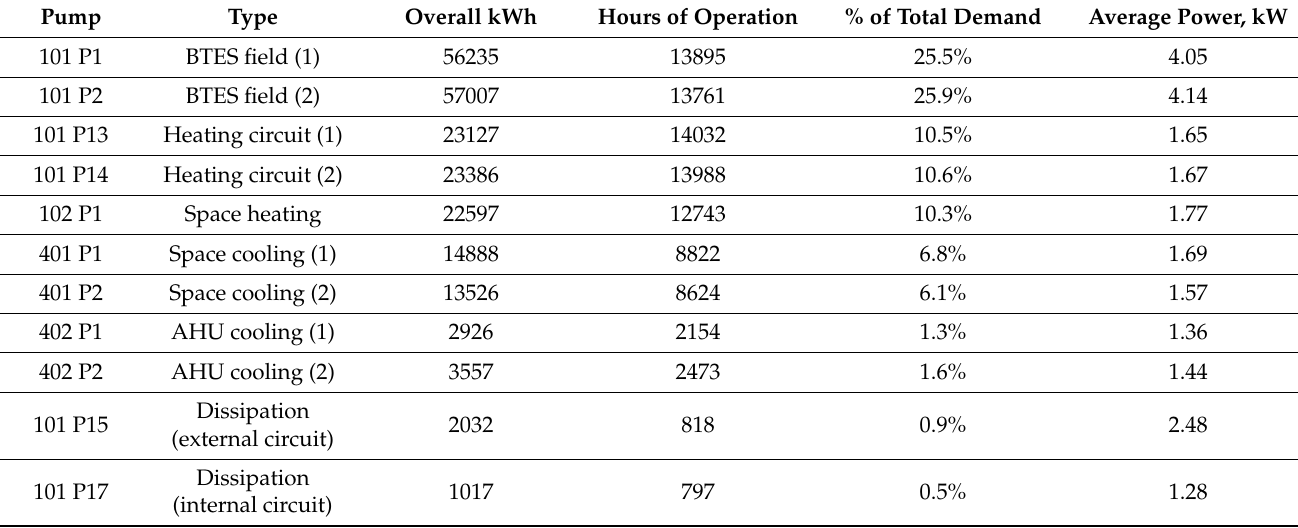
Table 2. HVAC pumps: totalized measured data between 13 March 2018 and 16 June